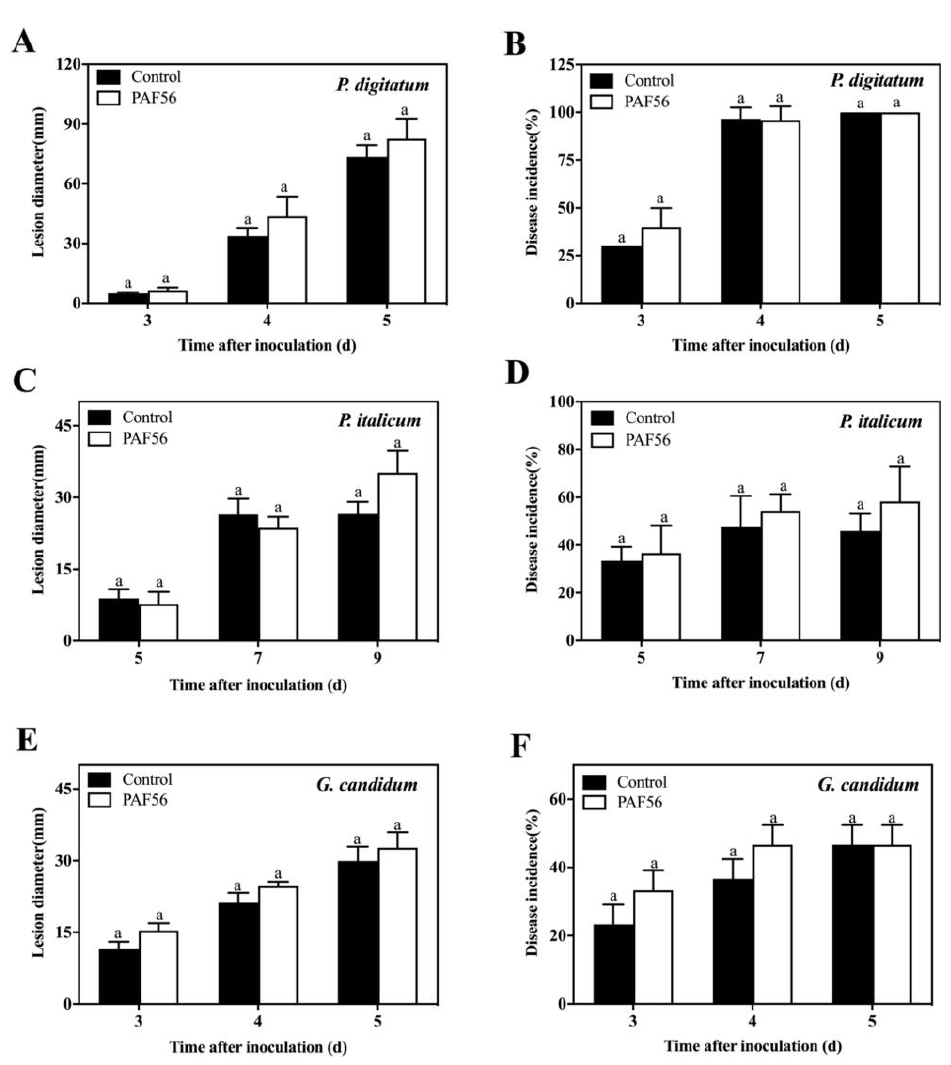
Figure 1. Effect of PAF56 (Inoculation in the different wounds) on lesion diameter and disease incidence of citrus fruit caused by P. digitatum ( A , B ), P. italicum ( C , D ), and G. candidum ( E , F ). Values are mean ± SD. The letters ‘a’ indicate no differences at the 0.05 level. The analysis was conducted using the data from the same pathogen on the same day.